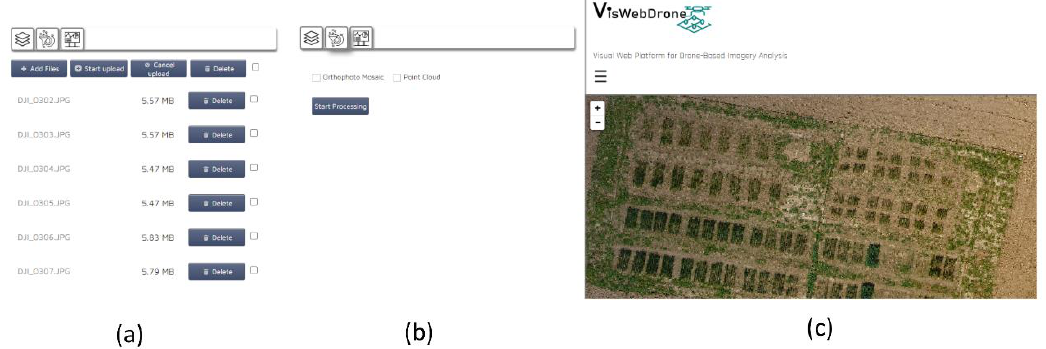
Figure 4. VisWebDrone functionalities and interface visualization: ( a ) upload of imagery; ( b ) type of output to process; and ( c ) visualization and analysis of the results.